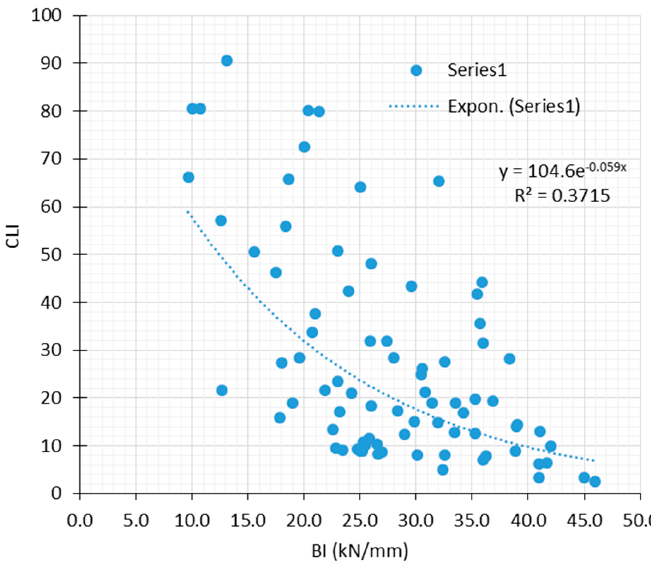
Figure 9. Relations between the BI and CLI.